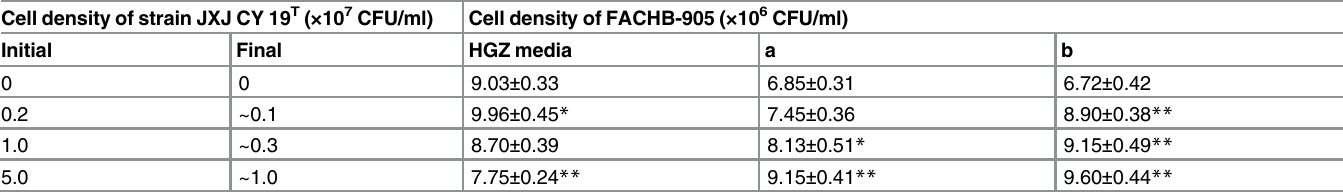
Statistical comparisons with the controls were made using ANOVA ( * P < 0.05, ** P < 0.01). a and b represented KH 2 PO 4 in HGZ media was replaced with Ca 3 (PO 4 ) 2 and L - α -phosphatidylcholine, respectively.